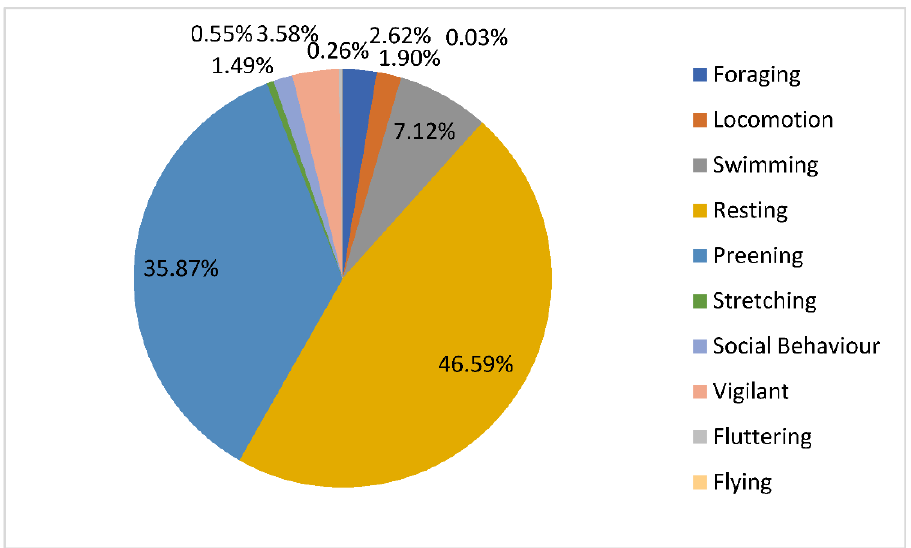
Figure 1. The average proportions of time spent by all 215 pelicans performing various behaviors. Overall, more than 46% of the time the observed pelicans were resting. The proportion of time spent preening by the animals was 35.9%. These were the most frequently observed activities. The proportion of swimming was only 7% and the proportion of vigilant pelicans was 3.5%. Other observed activity proportions were <3.5%. Figure 2 shows that the behavioral proportions differed between the zoos, but resting and preening were the two most frequently observed activities in each zoo. The proportion of swimming differed between 0% (two zoos) and 28%. One of the zoos showing no swimming behavior kept its pelicans in an aviary with a small pond and the other one without swimming behavior kept its pelicans in an aviary with a pond without fresh water delivery.